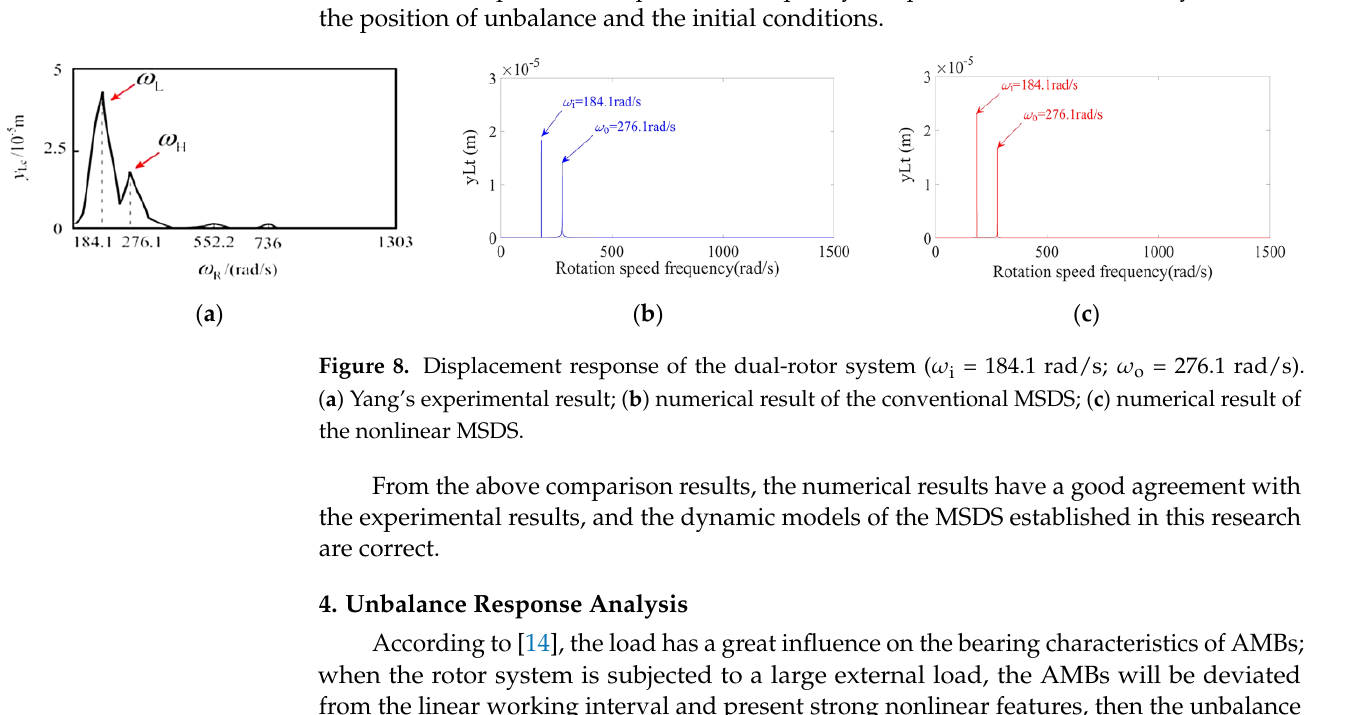
Figure 7. Displacement response of the dual-rotor system ( ω i = 252.6 rad/s; ω o = 301.2 rad/s). ( a ) Yang’s experimental result; ( b ) numerical result of the conventional MSDS; ( c ) numerical result of the nonlinear MSDS.